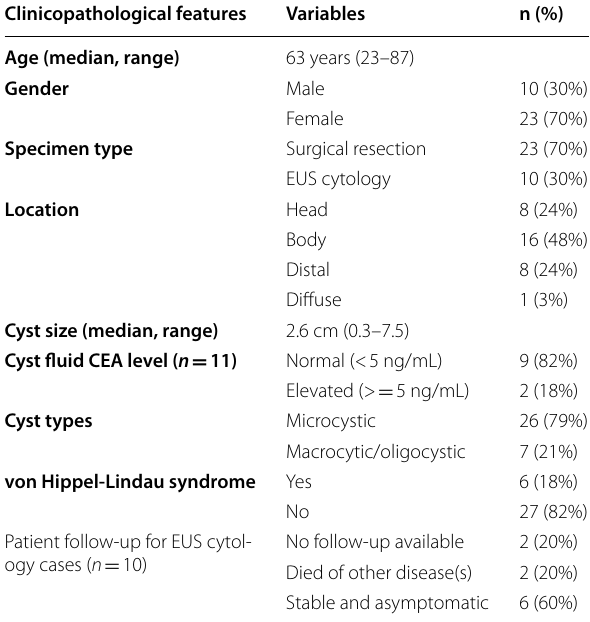
Table 1 Clinicopathological features of 33 patients with pancreatic serous cystadenoma Clinicopathological